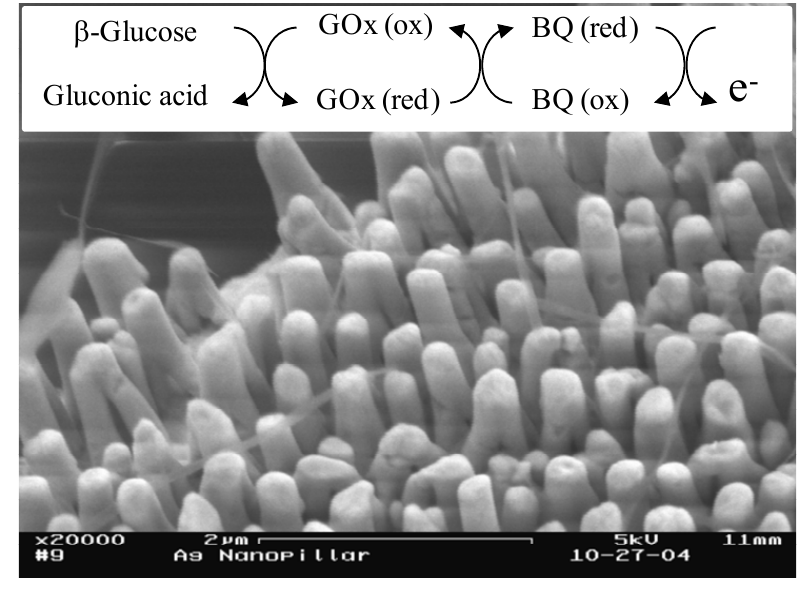
Figure 1. An SEM image of a typical nanopillar array modified 3D electrode. A scheme showing a cascade of events in a mediator-based glucose biosensor is shown in the